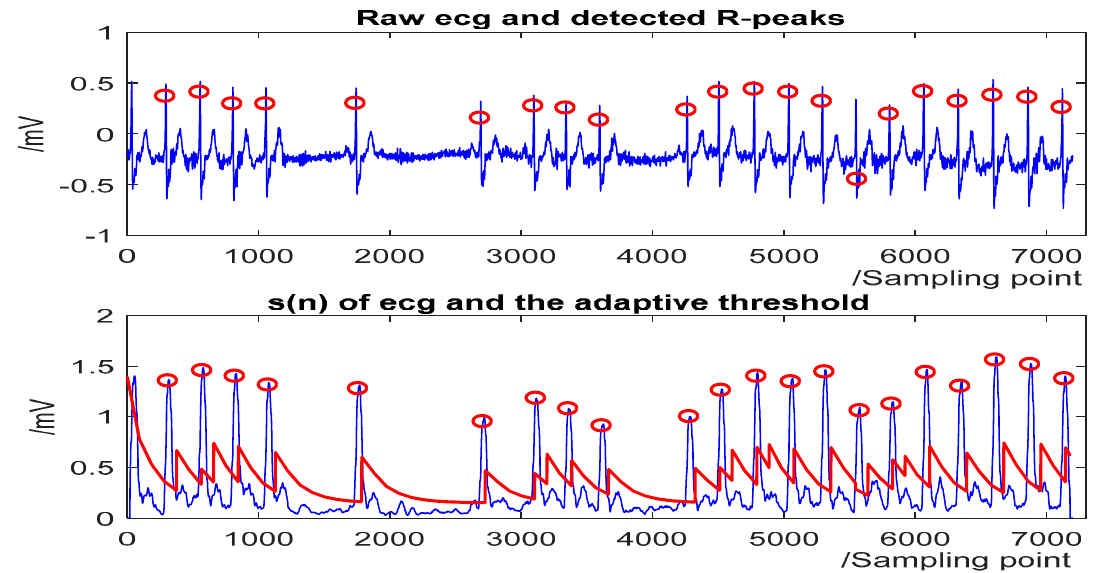
Figure 5. The QRS detection result of record 232 in the MIT-BIH Arrhythmia Database with sudden changes in RR interval and noises. ( Top ) the original ECG and detected R-peaks (red circle). ( Bottom ) s(n) in record 232 and the threshold (red line).